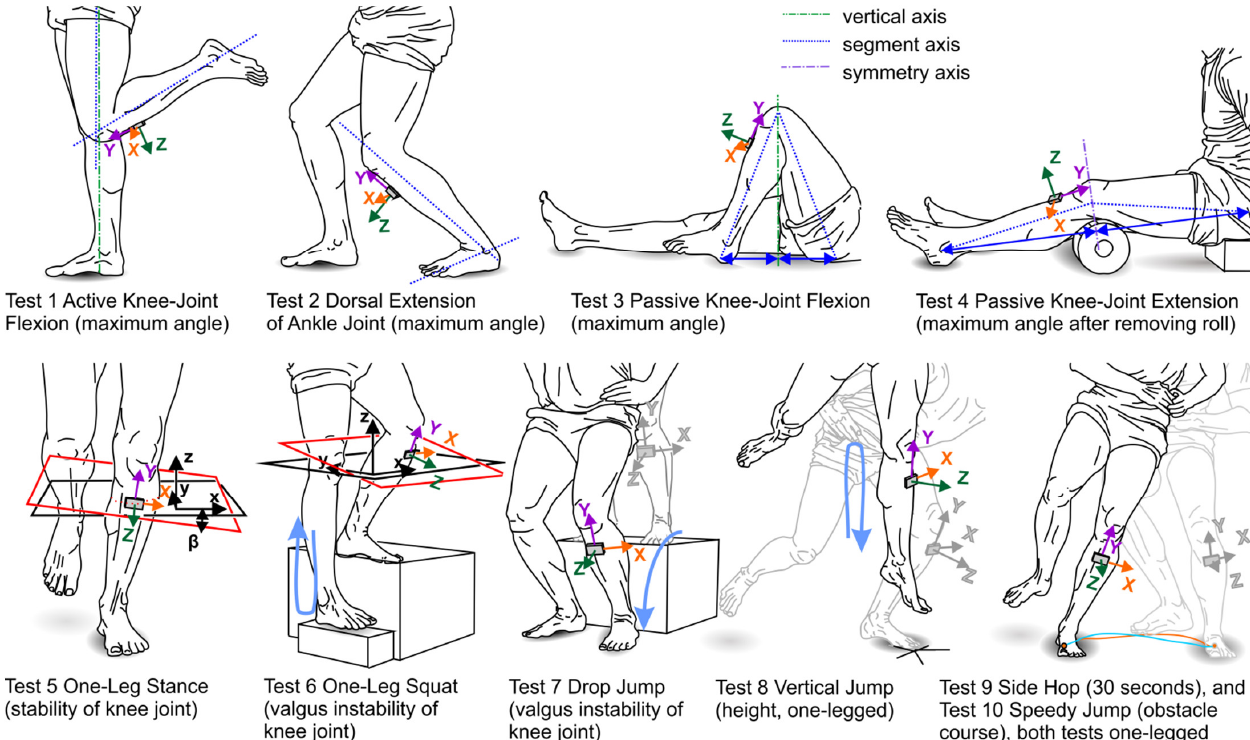
Figure 2. Motion patterns of the 10 tests provided by the IMU measurement system and examined in this study. this